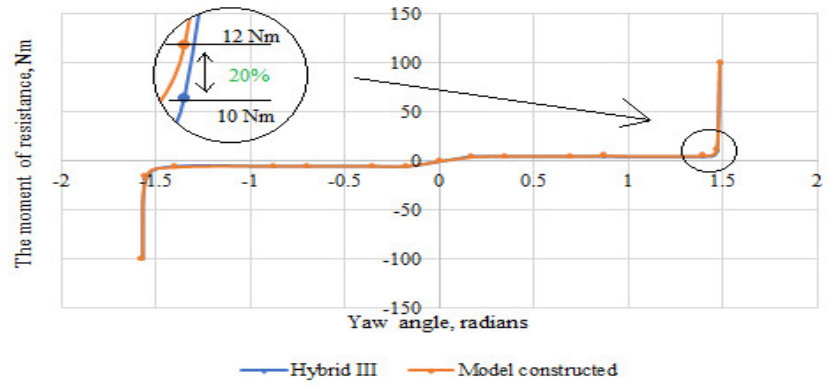
Figure 14. Summary of the stiffness characteristics of the elbow joint of the constructed anthropometric dummy with the Hybrid III dummy.